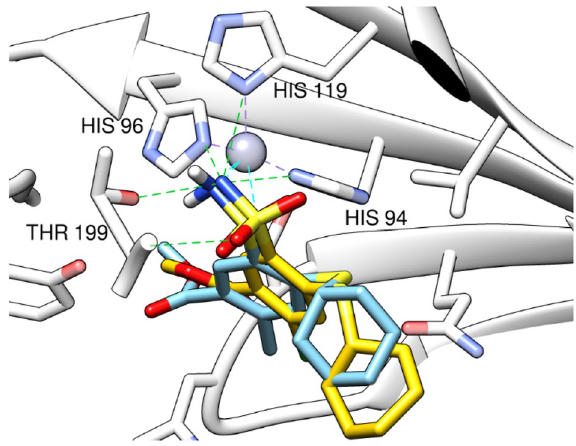
Figure 10. 3D interaction diagrams for CA IX (PDB ID: 7pom) (grey) with sulfonamide co-crystallized ligand (yellow) and its docked pose (cyan). Grey dashed lines: coordination of histidine triad with zinc, cyan dashed lines: coordination of compounds with zinc, green dashed lines: conventional hydrogen bonds.